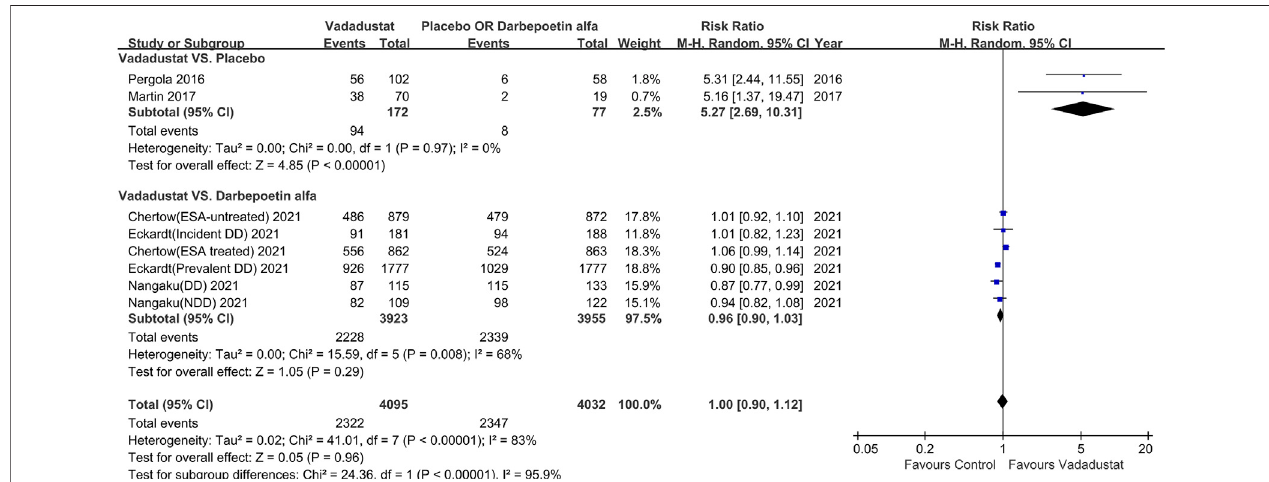
FIGURE 2 | Risk ratios of the Hb response rate for vadadustat versus placebo and darbepoetin alfa. Hb, hemoglobin. The registration number of Chertow (ESA- untreated) 2021 corresponds to NCT02648347; Chertow (ESA treated) 2021 corresponds to NCT02680574, Eckardt (incident DD) 2021 corresponds to NCT02865850,Eckardt(prevalentDD)2021correspondstoNCT02892149,Nangaku(NDD)2021correspondstoNCT03329196,Nangaku(DD)2021correspondsto NCT03439137.